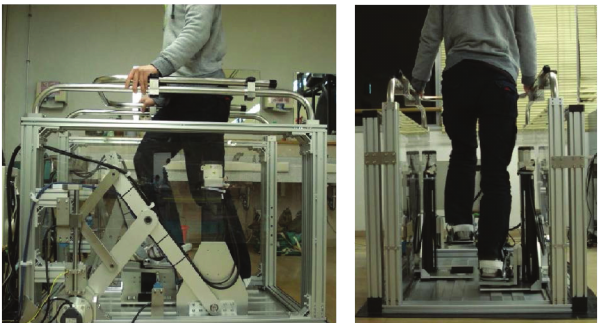
Figure 1: System overview of the GM5.